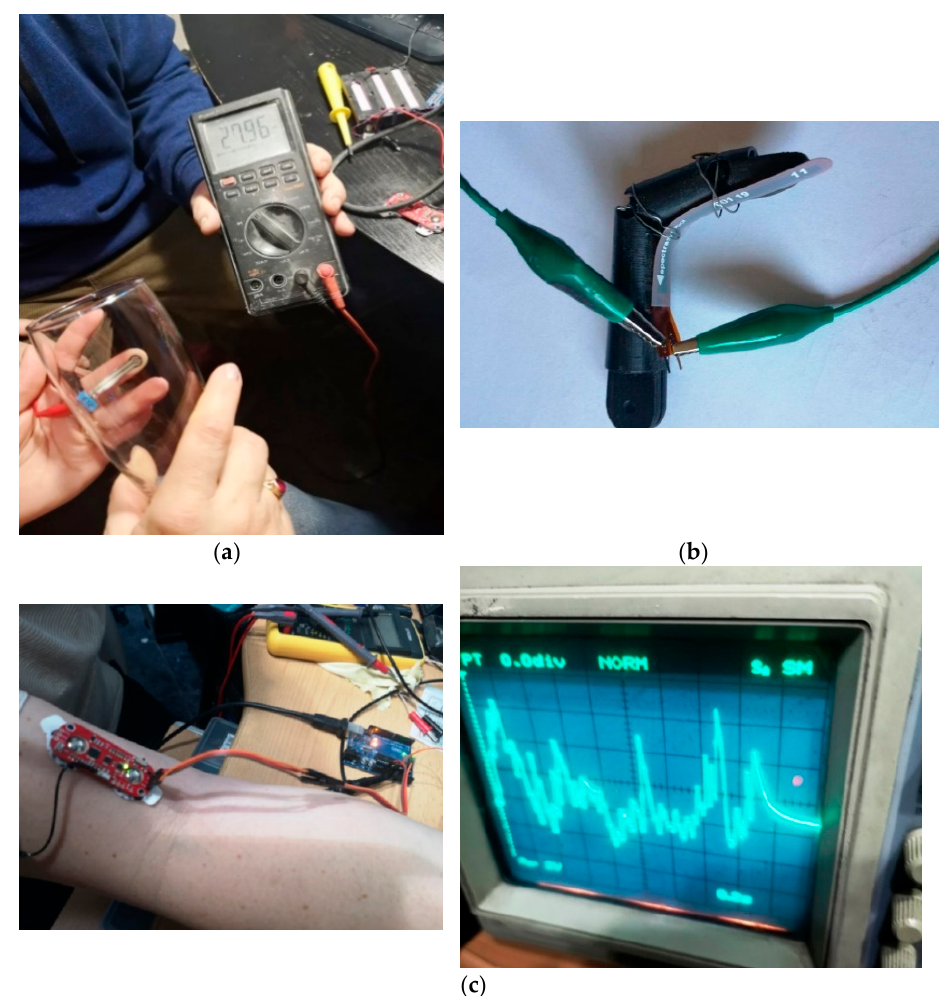
Figure 15. Experiments on the sensors. ( a ) FSR pressure sensors—for force, ( b ) tilt sensor—for finger inclination angle, ( c ) EMG sensor test.